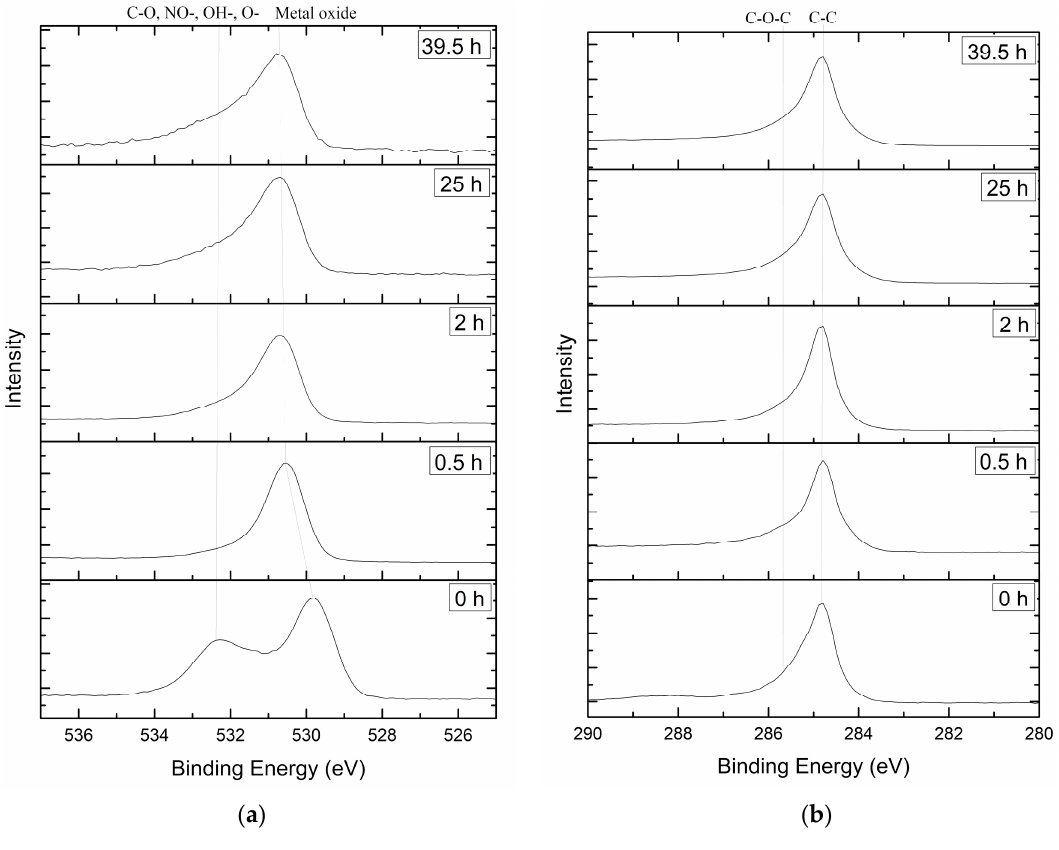
Figure 5. XPS element spectra of the etched surface: ( a ) O1s; ( b ) C1s.